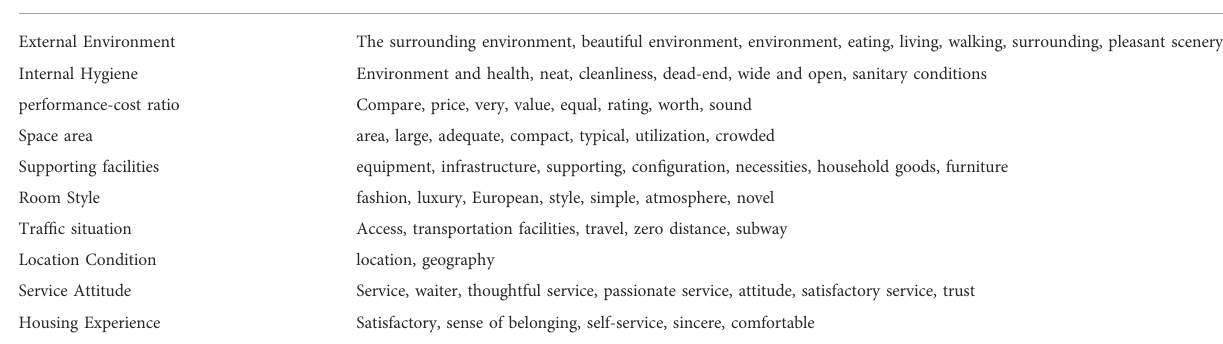
TABLE 1 Similar vocabulary arrangement.